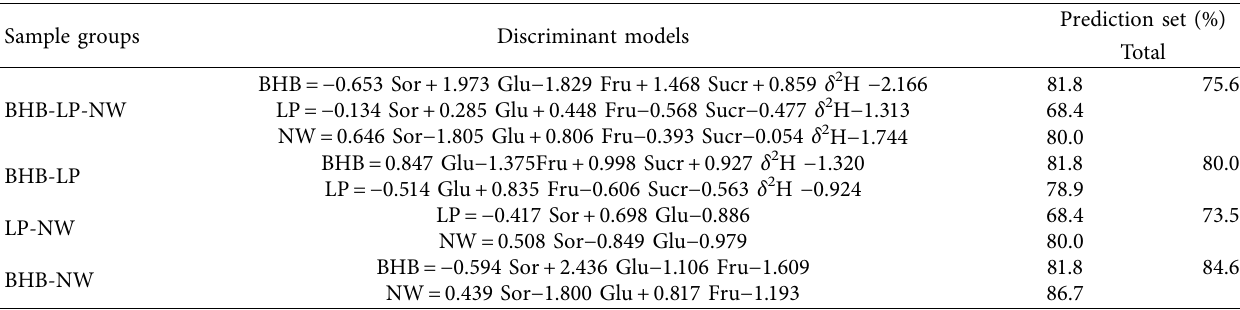
Table 6: The correct discrimination rate of discrimination model for prediction